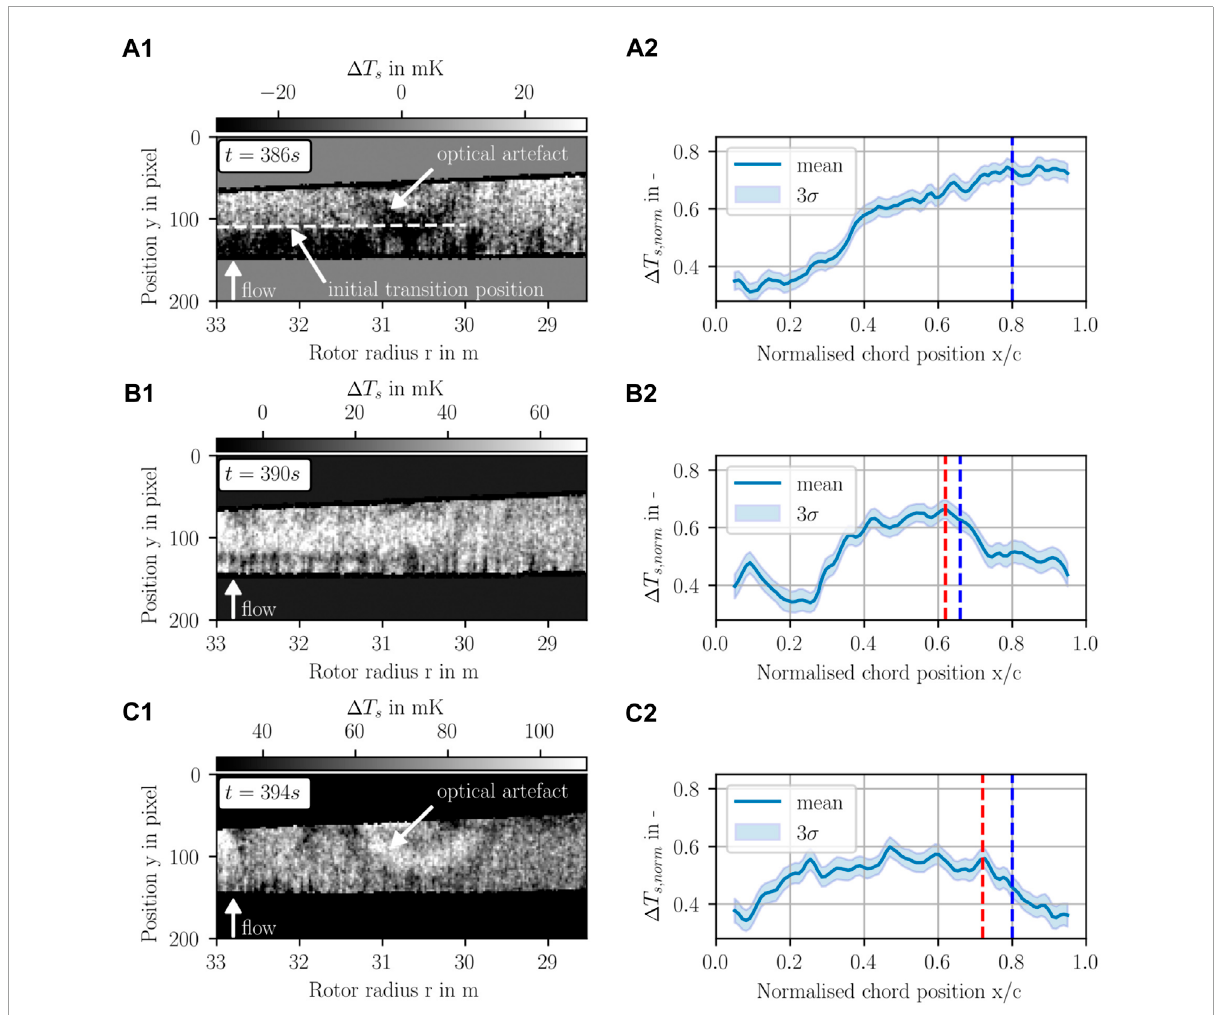
FIGURE 8 Evaluation of thermographic images using the DIT approach for a time range with unsteady flow separation. Left: processed difference images for different times, right: over the rotor radius, excluding the region with the optical artefact, averaged profiles over the normalised chord position. Flow separation is detected by identifying a local maximum and a subsequent clear decrease towards the trailing edge in the signal curves of (B) 2 and (C) 2 at x / c = 0 . 62 and x / c = 0 . 72, respectively (red dashed lines). Blue dashed lines: tufts measured separation